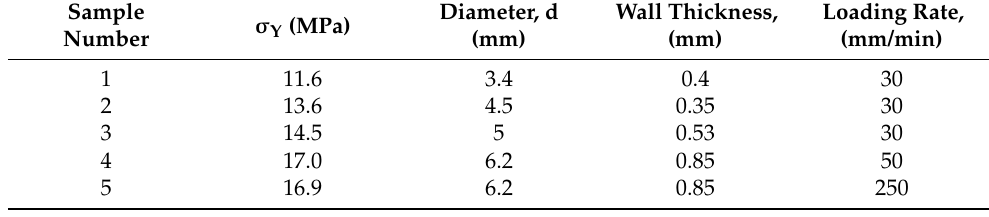
Table 3. Mechanical properties of samples.